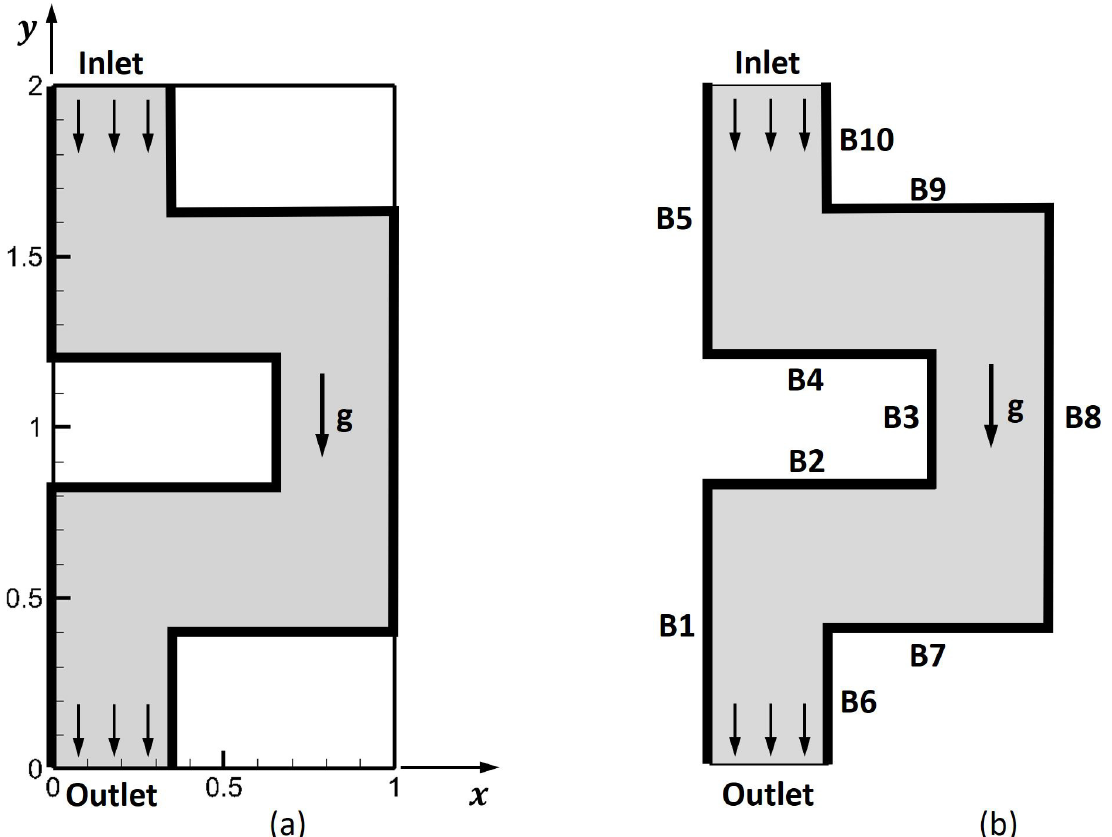
Figure 3. Schematic of flow domain in a multiple right bending pipe driven by gravitational force: ( a ) flow domain and boundary conditions; ( b ) labels used in the wall boundary. The bold solid line indicates wall